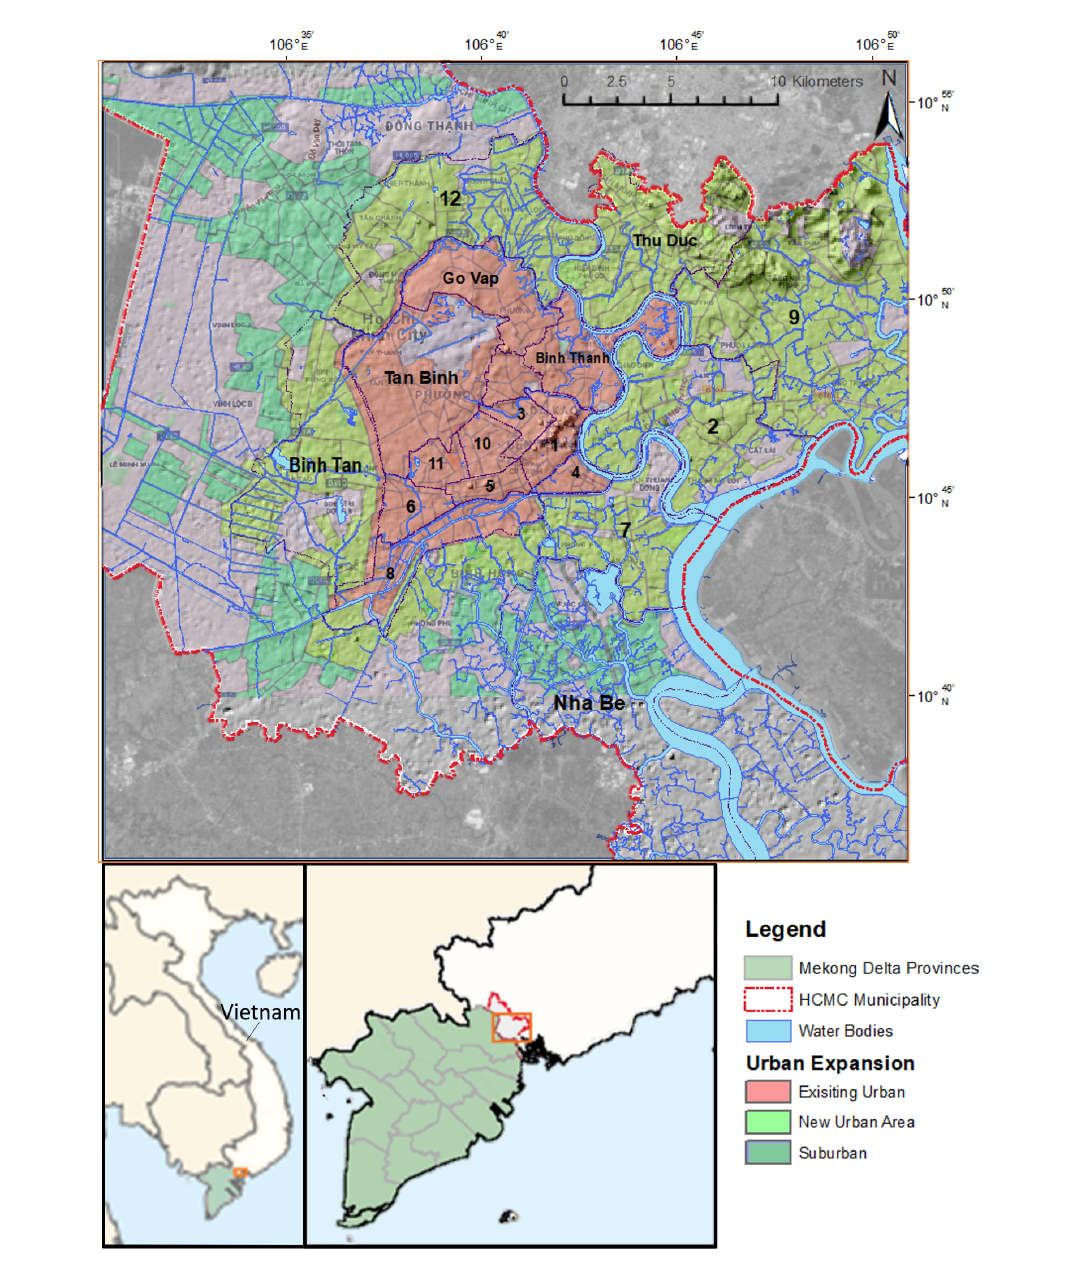
Figure 1. Study area of Ho Chi Minh City (HCMC) depicted as orange box in the lower right southern Vietnamese subset, masked by the municipal boundary of HCMC and with key districts of analysis and recent urban expansion where new urban zones are those with buildings erected primarily after 2008 while existing urban zones are comprised of buildings erected primarily before 2008, from the HCMC Dept. of Urban Planning and